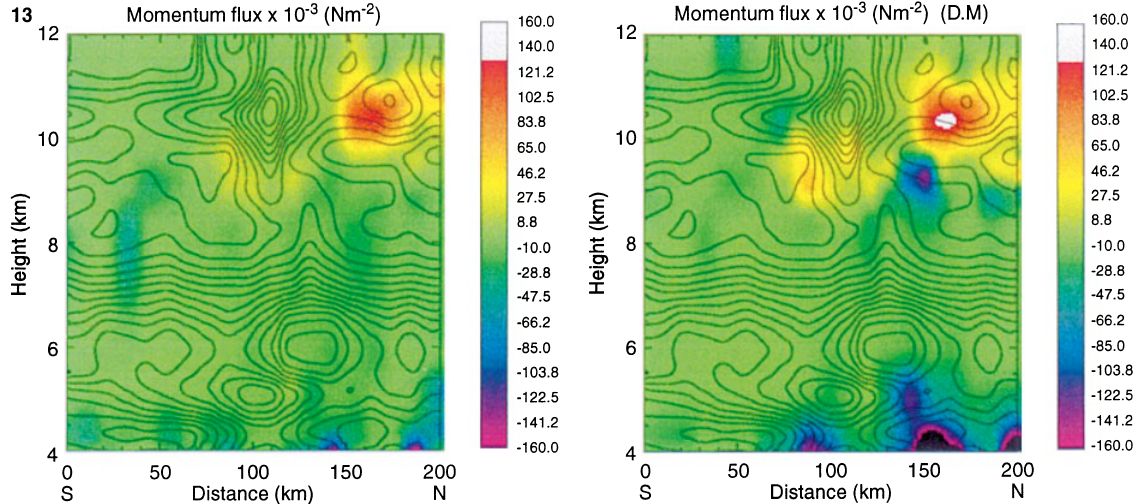
Fig. 13. Colors : turbulent momentum flux (in N m (cid:255) 2 ) computed by eddy-correlation ( left ) and inertial-dissipation ( right ) method. The black isolines reproduce the horizontal wind presented in Fig. 8, e. g. from 15 October